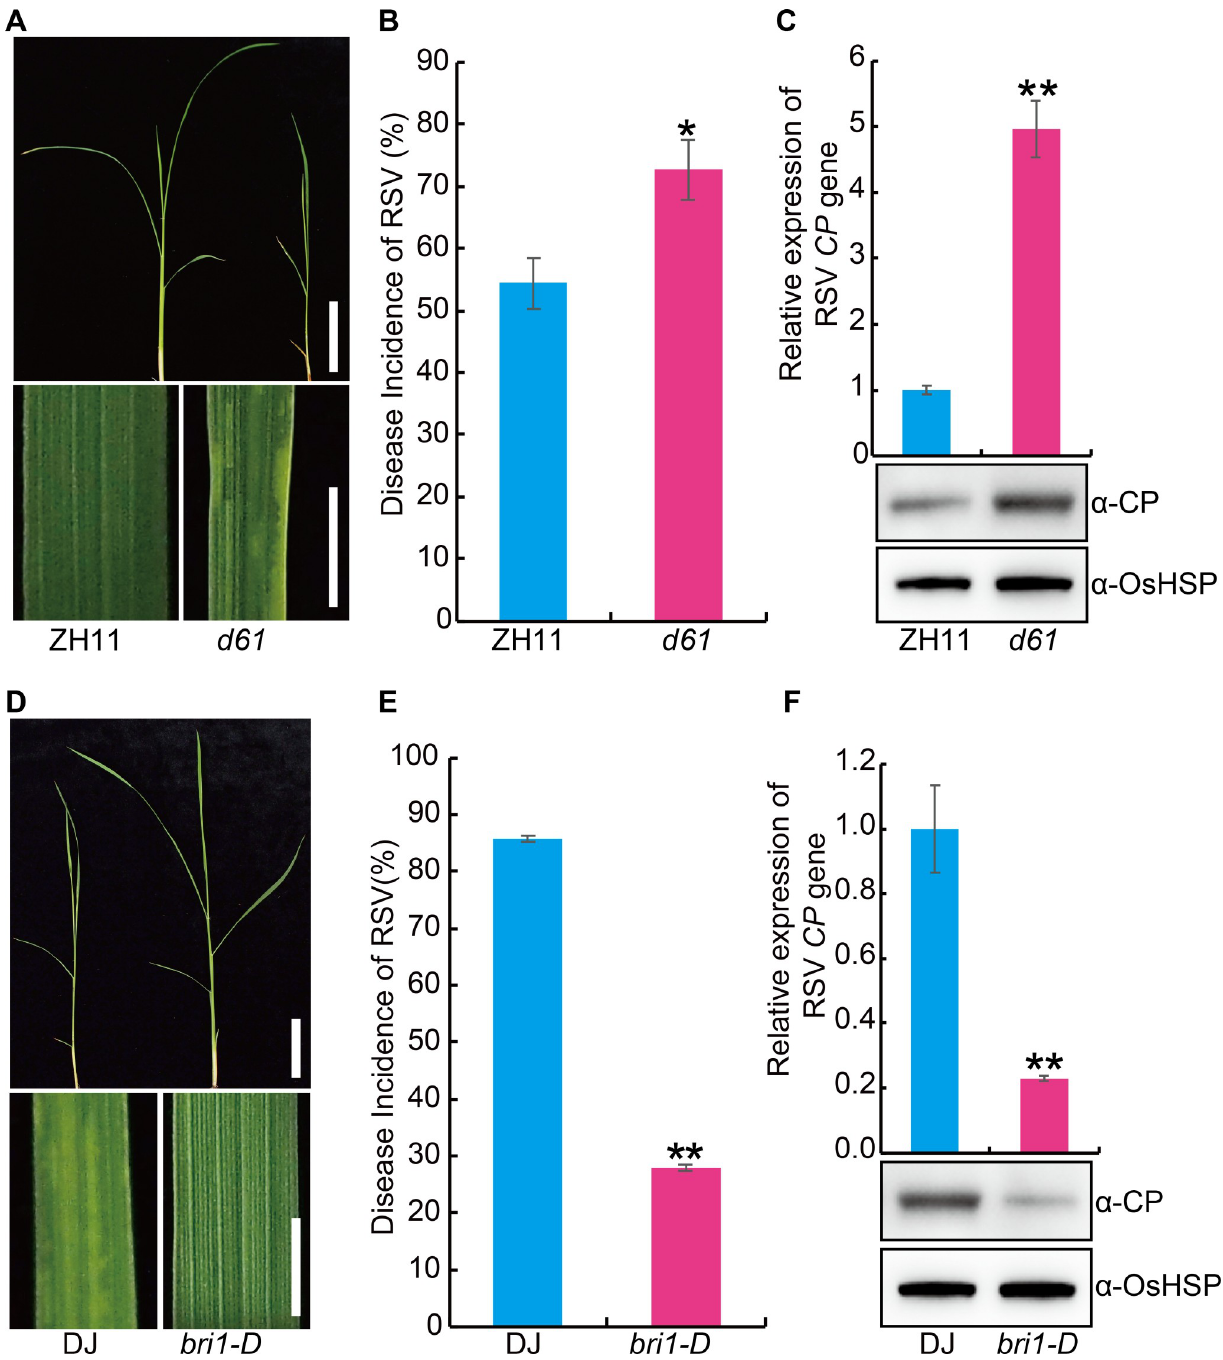
Fig 2. OsBRI1 plays a positive role in the resistance against RSV in rice. (A) Representative image of the BR INSENSITIVE 1 ( BRI1 ) deficient mutant d61 and its wild-type Zhonghua11 (ZH11) seedlings infested with RSV-carrying SBPH. Bar = 5 cm (top). Bar = 3 mm (bottom). (B) RSV incidence of d61 and ZH11 at 30-day post infection (dpi) with RSV-carrying SBPH. (C) Detection of RSV CP RNA expression levels (upper panel) by quantitative RT– PCR assay and western blot analysis of the RSV coat protein (lower panel) in the RSV-infected d61 and ZH11 plants, respectively. OsHSP was used as loading control. (D) Representative image of the BRI1- activated lines bri1-D and its wild-type Dongjin (DJ) seedlings infested with RSV-carrying SBPH. Bar = 5 cm (top). Bar = 3 mm (bottom). (E) RSV incidence of bri1-D and DJ at 30 dpi with RSV-carrying SBPH. (F) Detection of RSV CP RNA expression levels (upper panel) by quantitative RT–PCR assay and western blot analysis of the RSV coat protein (lower panel) in the RSV-infected bri1-D and DJ plants, respectively. OsHSP was used as loading control. Data are shown as mean ± SEM (n = 3). � P < 0.05, �� P < 0.01 by Student’s t -test in B, C, E and F.